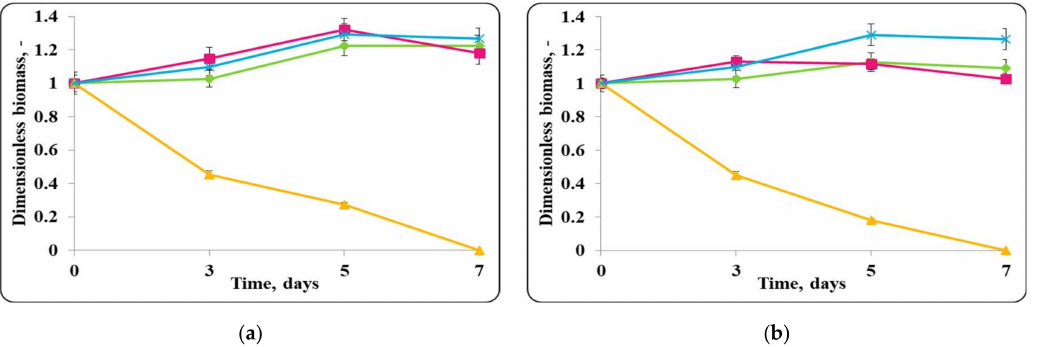
Figure 13. ( a ) free lactobacilli cells; ( b ) encapsulated lactobacilli cells. Changes in the dimensionless biomass of Lb. helveticus 2/20 and S. aureus ATCC 25923 in MRS broth at 20 ± 2 ◦ C. Legend: Green (cid:117) : Lb. helveticus 2/20 population following its inoculation; Pink (cid:4) : Lb. helveticus 2/20 population following its co-inoculation with S. aureus ATCC 25923; Blue × : S. aureus ATCC 25923 population following its direct inoculation; Yellow (cid:78) : S. aureus ATCC 25923 population following its co-inoculation with Lb. helveticus 2/20.